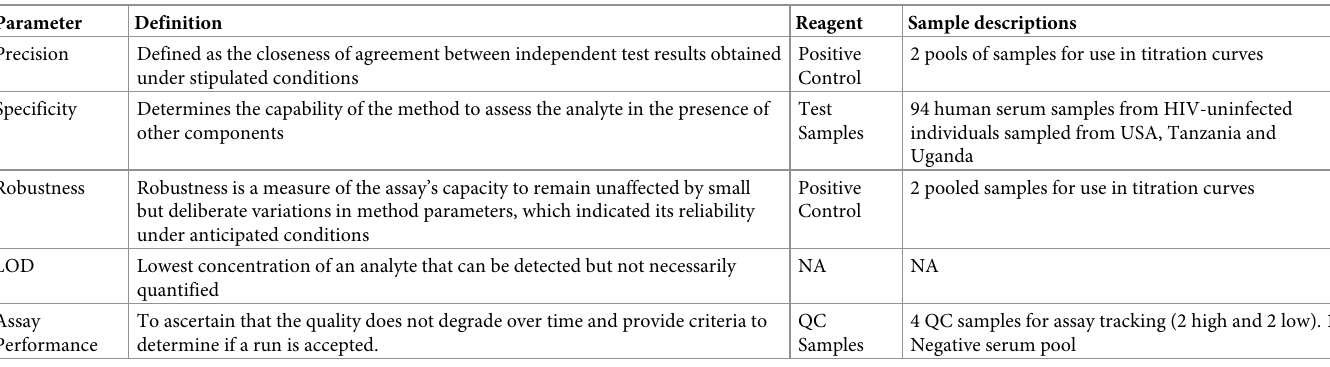
Table 1. Validation assay parameters and control